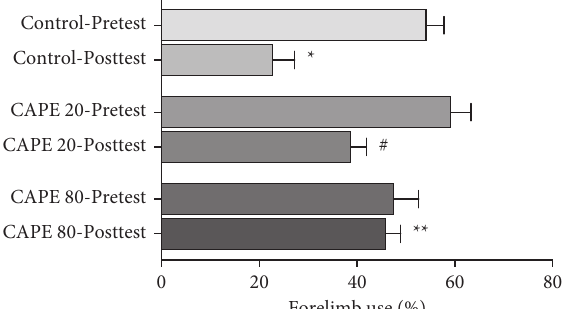
Figure 4: Data were presented as the left forepaw contacts as a percentage of the total number of contacts of each forepaw. Preferences in the forelimb usage of groups are given. Control group, n � 7; CAPE 20 group, n � 9; CAPE 80 group, n � 8 ( ∗ p < 0 . 01 versus control-pretest; # p < 0 . 05 versus CAPE 20-pre- test; and ∗∗ p < 0 . 01 versus control